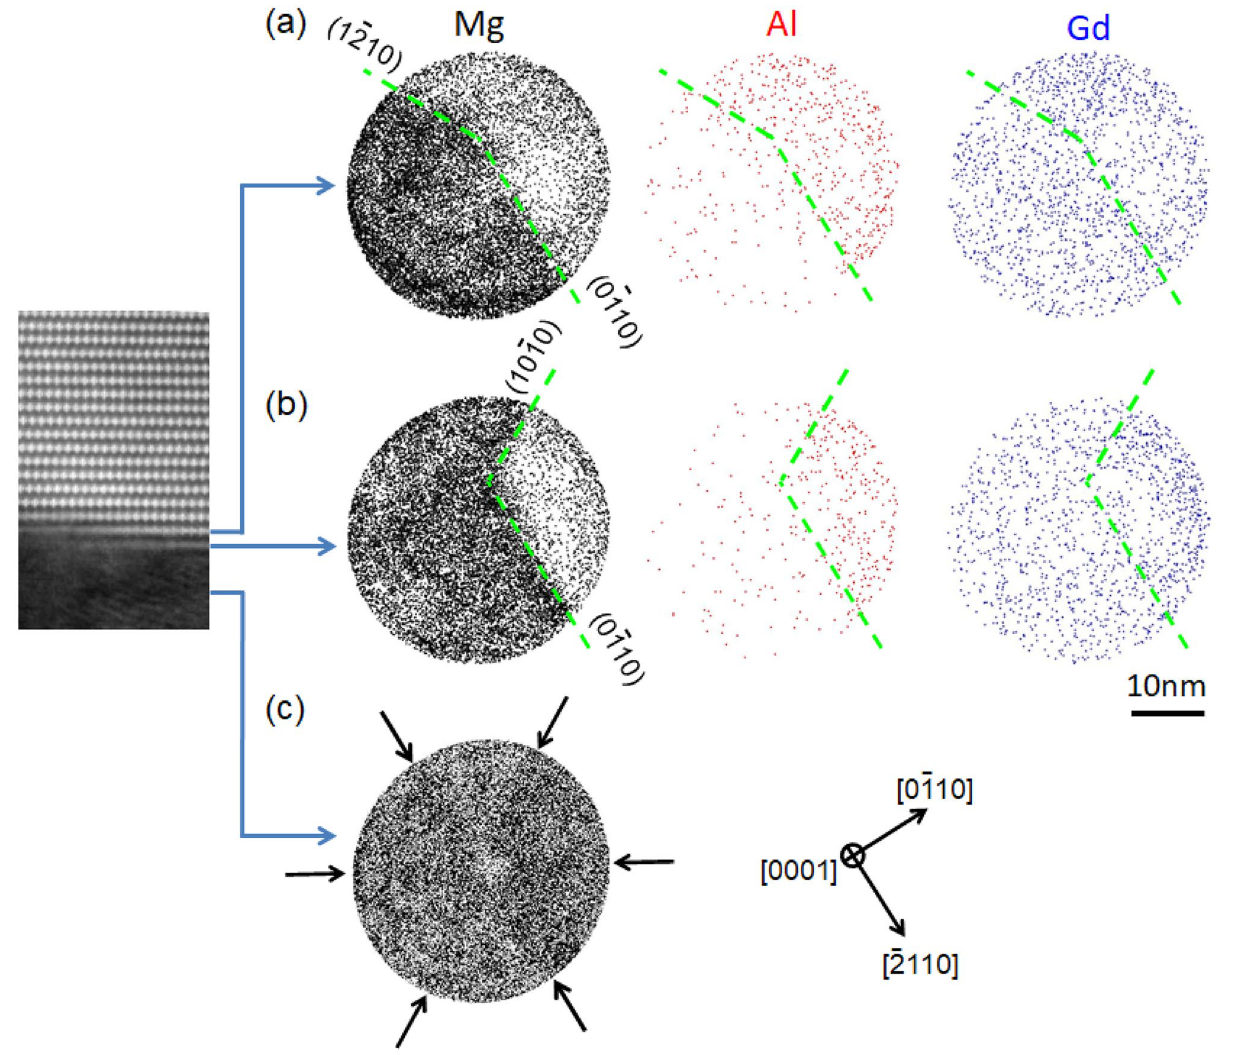
Figure 4. ( a , b ) Cross-sectional views of the APT maps at the enriched layers in the interface region of the LPSO/OD and α-Mg phases observed from the [0001] direction. The enriched layers correspond to those marked by the solid arrows in the HAADF-STEM image. ( c ) Cross-sectional view of the Mg map in the region of the α-Mg phase observed from the [0001] direction. The region of the α-Mg phase corresponds to that in the HAADF-STEM image marked by the solid arrow. The HAADF-STEM image is the same image as that in Fig. 3a. Software: ( a – c ) Integrated Visualization and Analysis Software (IVAS), Ver. 3.6.14, https ://www.camec a.com/ servi ce/softw